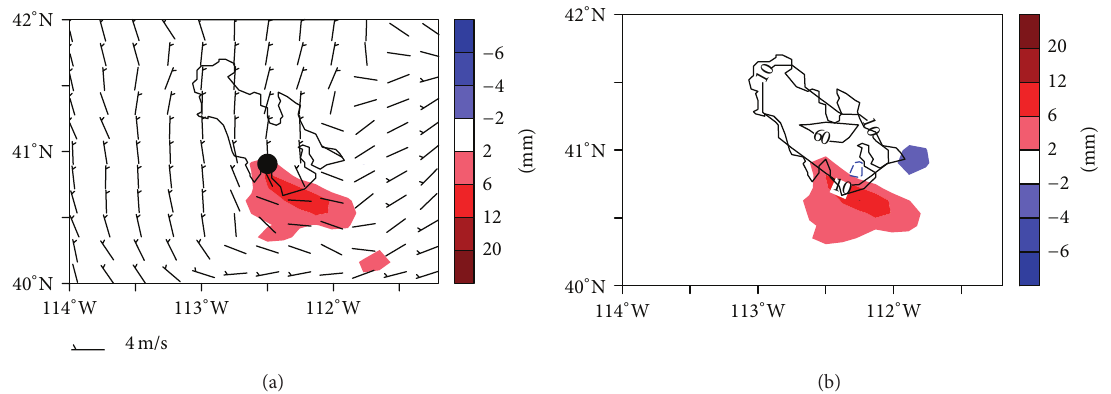
Figure 11: Simulated precipitation difference ((a), (b), shade) between SL and NL (a) and between SL and FL (b), simulated wind filed ((a), barb) in SL experiment and simulated LH ((b), contour) between SL and NL ((b), contour with black line) and between FL and NL ((b), contour with blue line) in the second GSL precipitation event.